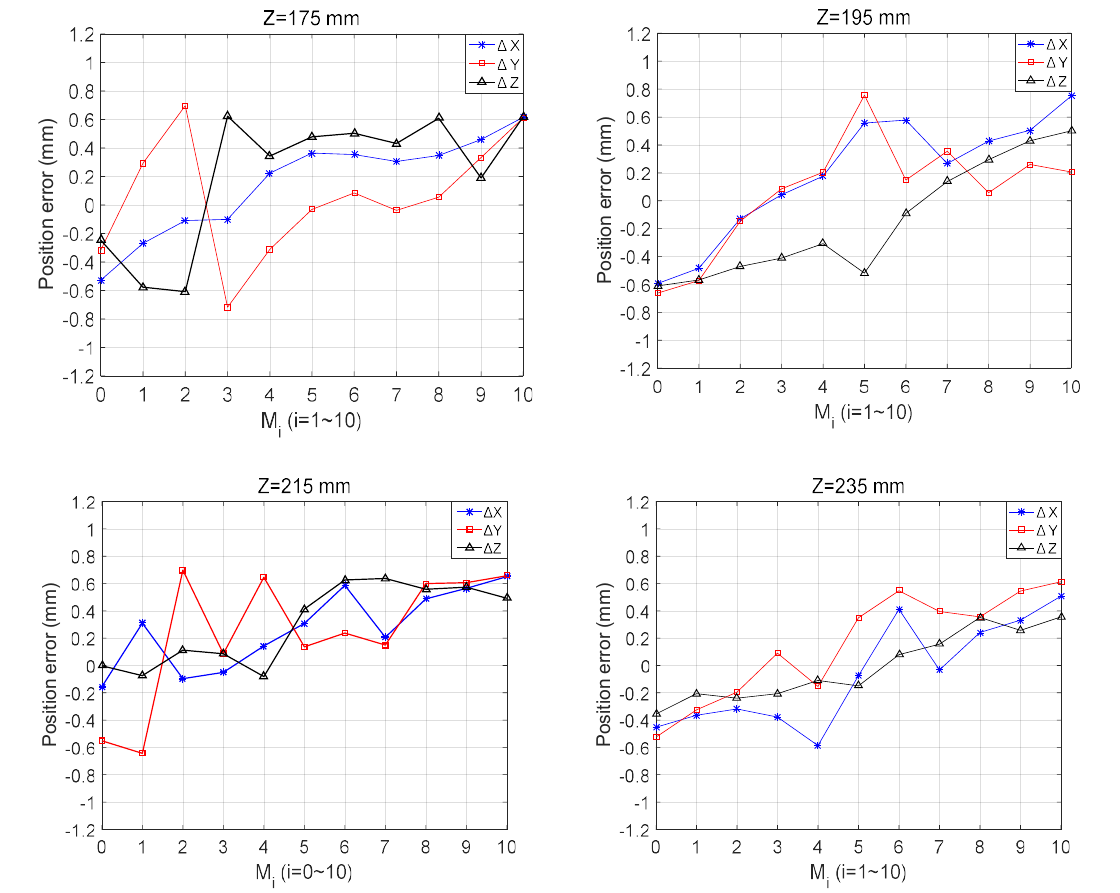
Figure 14. The error distributions of the end-effector after calibration.